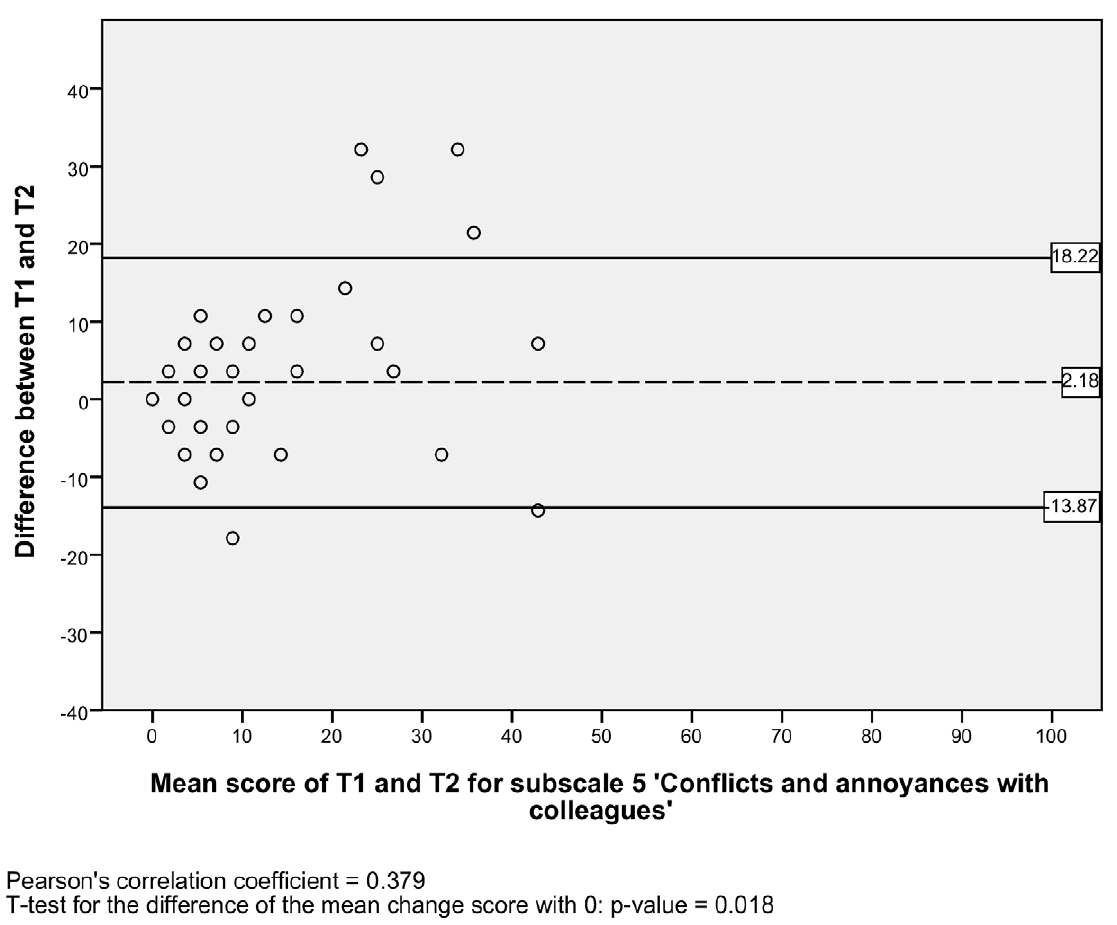
Figure 5. Bland and Altman plot for subscale 5 ‘Conflicts and irritations with colleagues’.